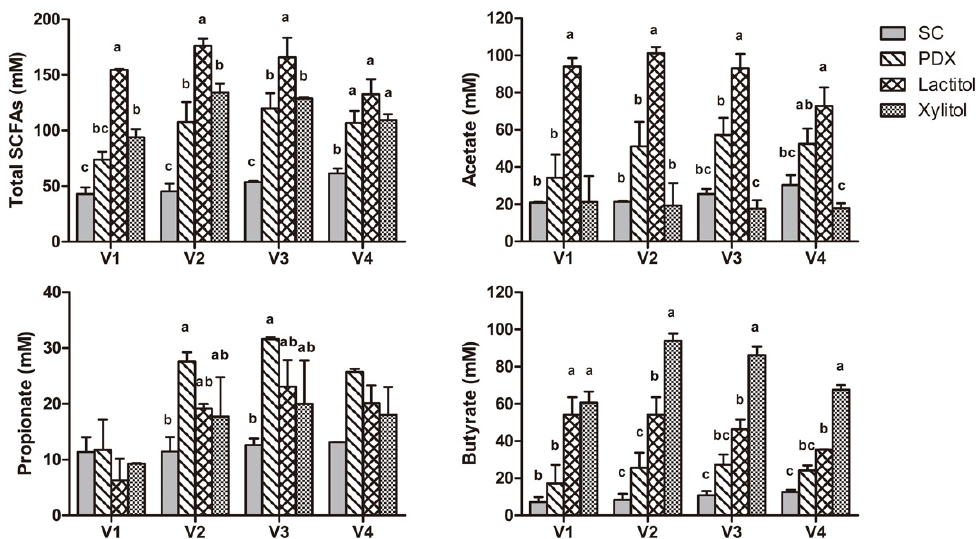
Figure 2. Production of total and major SCFAs during in vitro fermentation. Polydextrose (PDX), lactitol and xylitol was fermented in vitro by the EnteroMix fermentation model, and simulation medium was used as simulation control (SC). V1–V4, vessel 1 to vessel 4, represent the ascending, transverse, descending and sigmoid colon. The production of acetate, propionate, butyrate and total SCFAs is presented as mean ± SEM of two fermentations (n = 2). Within each vessel (V1–V4), bars with different letters differ significantly at p < 0.05 according to Tukey’s test.